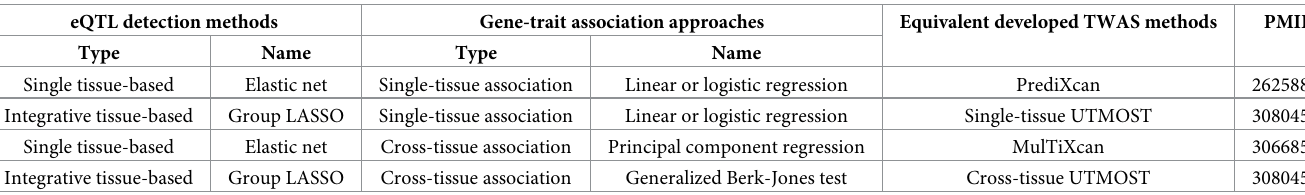
Table 1. TWAS methods tested in this simulation